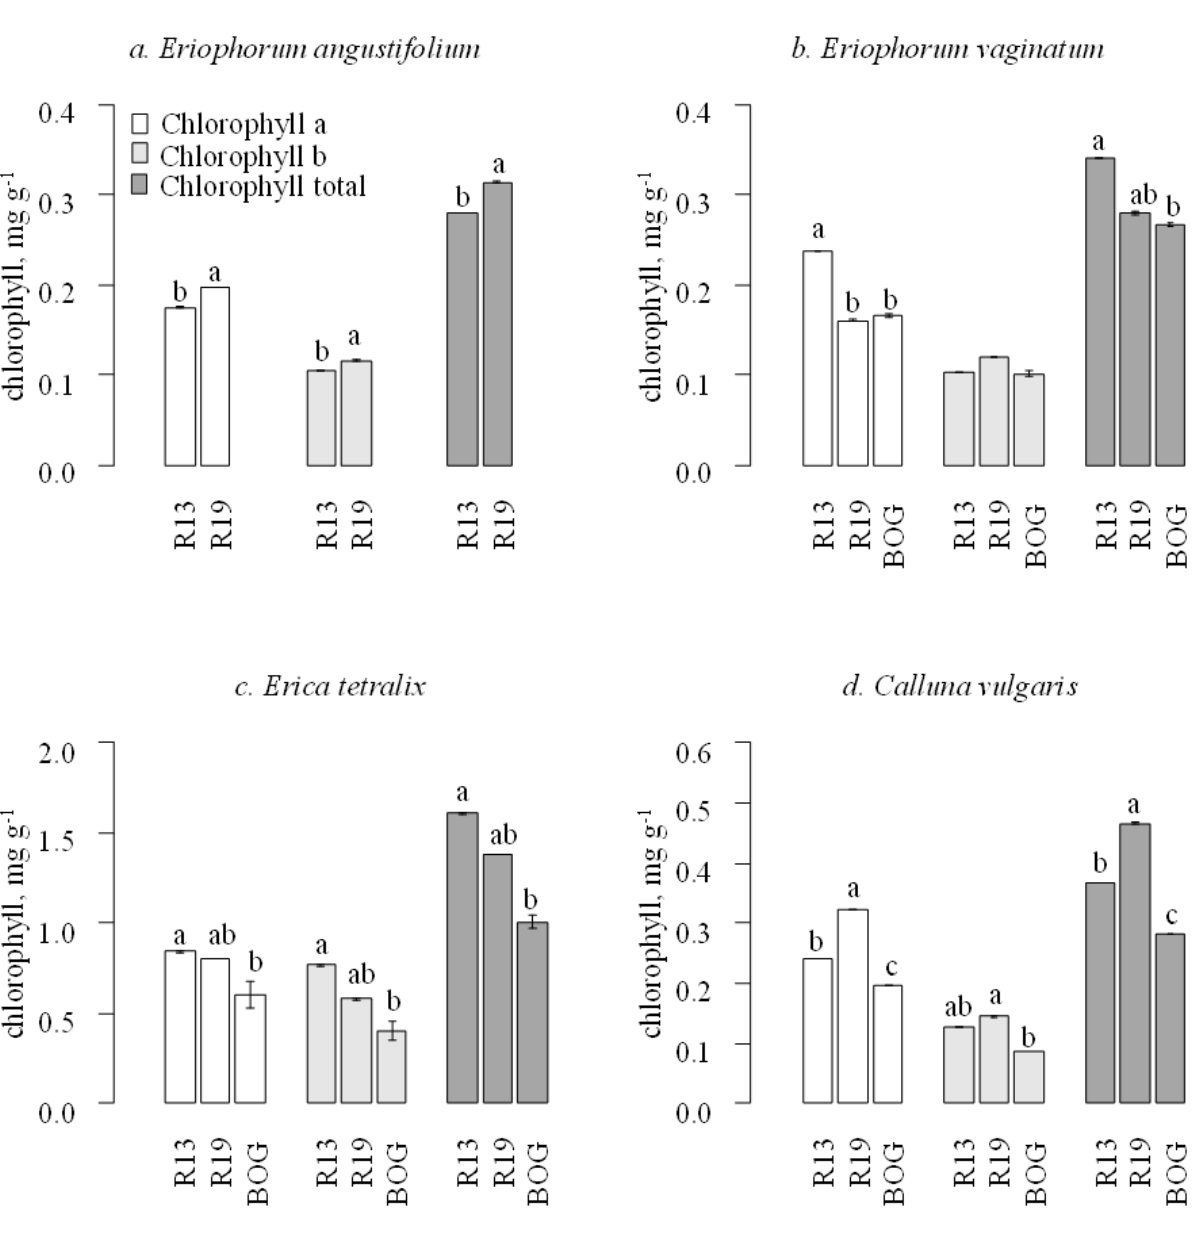
Figure 4. Mean and standard errors for chlorophyll concentrations (n = 3) measured in leaves of a) Eriophorum angustifolium , b) Eriophorum vaginatum , c) Erica tetralix and d) Calluna vulgaris . R13 = forest-to-bog site aged 13 years; R19 = forest-to-bog site aged 19 years, BOG = open blanket bog control. The letters above the bars indicate significant differences, i.e. within a type of chlorophyll; where letters differ there was a significant effect of site. (p <